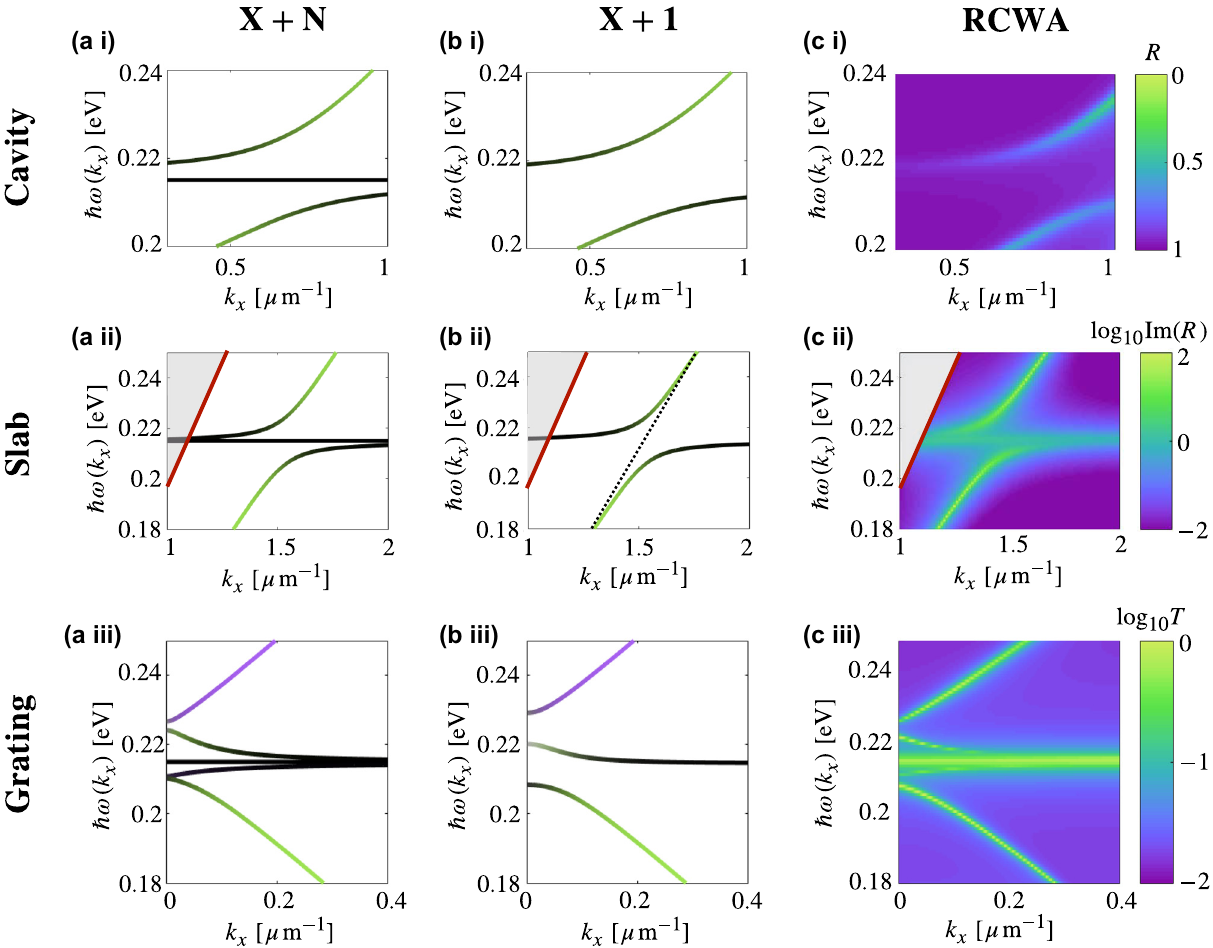
Figure 5: Comparing X + N versus X + 1 model: (a) Dispersion relation for N molecules strongly coupled to (i) the mode of a planar optical cavity, (ii) an SP at a gold/air interface and (iii) backwards and forwards travelling SPs on a grating. All dispersion relations calculated using a X + N mode. (b) The same dispersion relations calculated using the equivalent X + 1 models. (c) The same systems simulated using